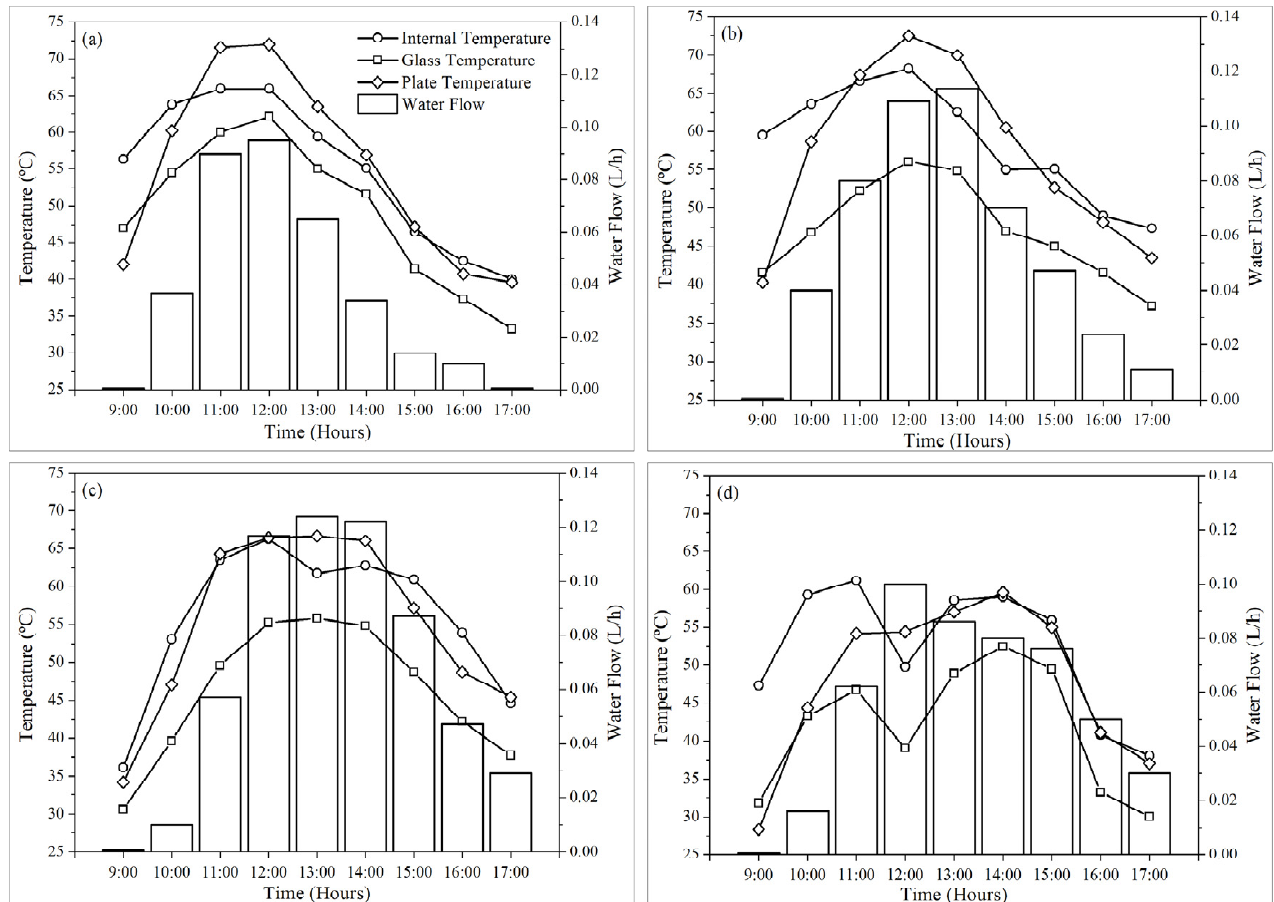
Figure 7. Desalinated water and temperatures for tests ( a ) 1; ( b ) 2; ( c ) 3; and ( d ) 4.